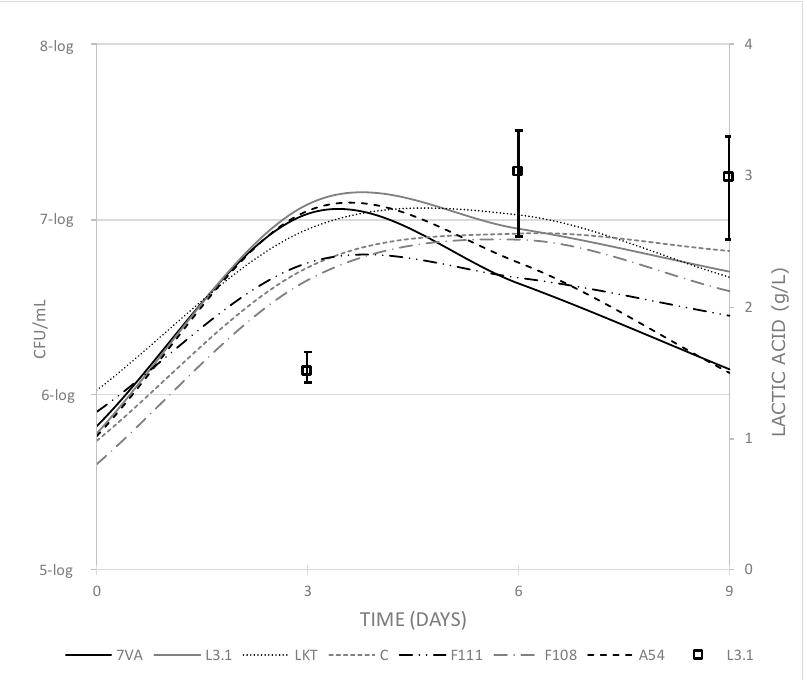
Figure 4. Cell counts of each yeast (CFU/mL) along fermentation compared with the production of lactic acid by Lt L3.1 (squares) and error bars, showing the range of lactic acid values for all the tested strains in the 1 L trial.